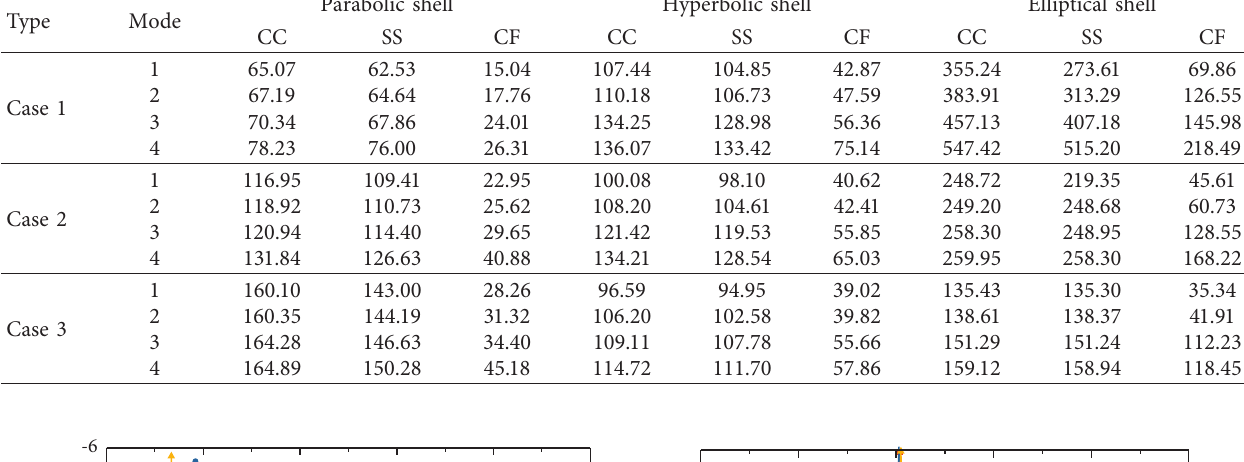
Table 9: First four frequencies for Type 2-2 Sandwich FGP doubly curved structure with diverse boundary conditions. Type